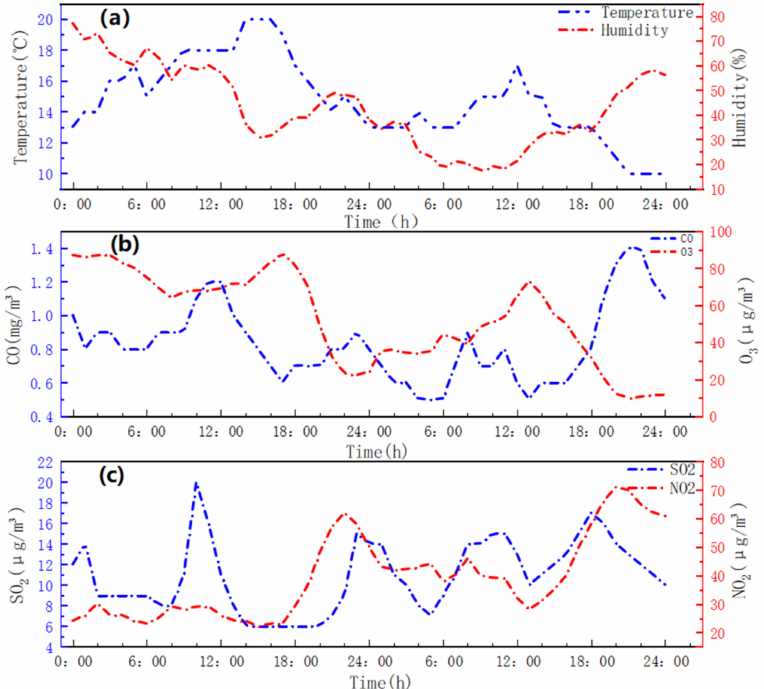
Figure 6. Comparison of the amplitudes of the changes on 27 and 28 March 2021: ( a ) temperature and relative humidity (RH); ( b ) CO and O 3 ; ( c ) SO 2 and NO 2